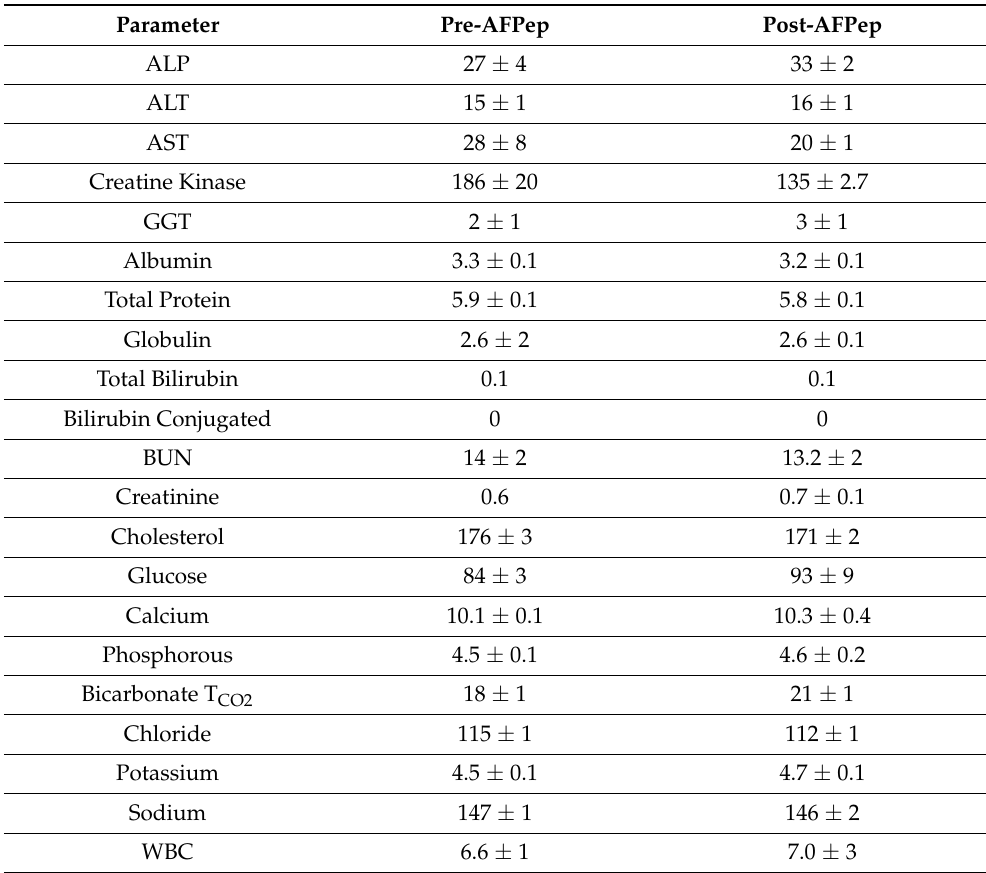
Table 3. Blood chemistry and hematology values before and 24 h after intravenous administration of 40 mg AFPep to